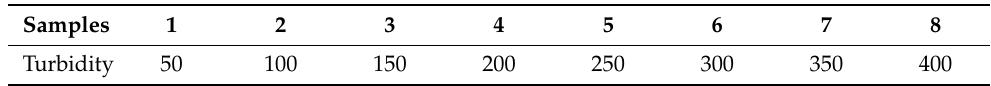
Figure 1. Particle size distribution of Chlorella (light microscope image at 40 × magnification). Table 1. Turbidity of standard solutions